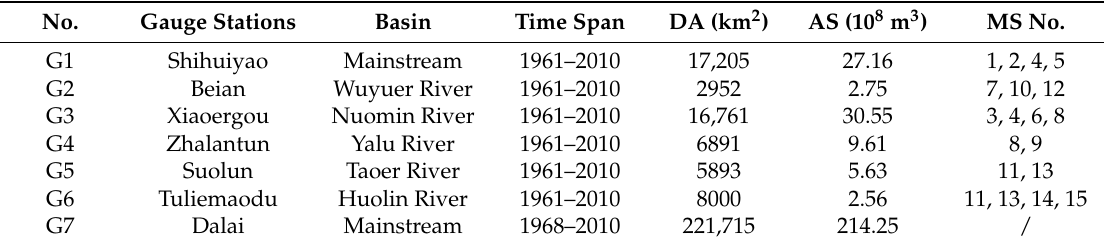
Table 1. Summary of river gauge stations, tributaries, representing drainage area (DA), annual streamflow (AS), and the identification numbers of meteorological stations (MS No.) in the headwater regions of the Nenjiang River Basin, Northeast